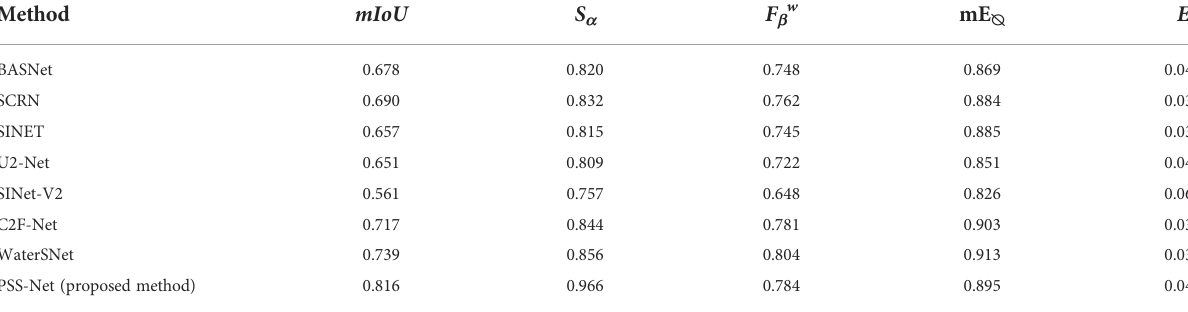
TABLE 6 Comparison of proposed PSS-Net and state-of-the-art methods with MAS3K dataset (case 2).